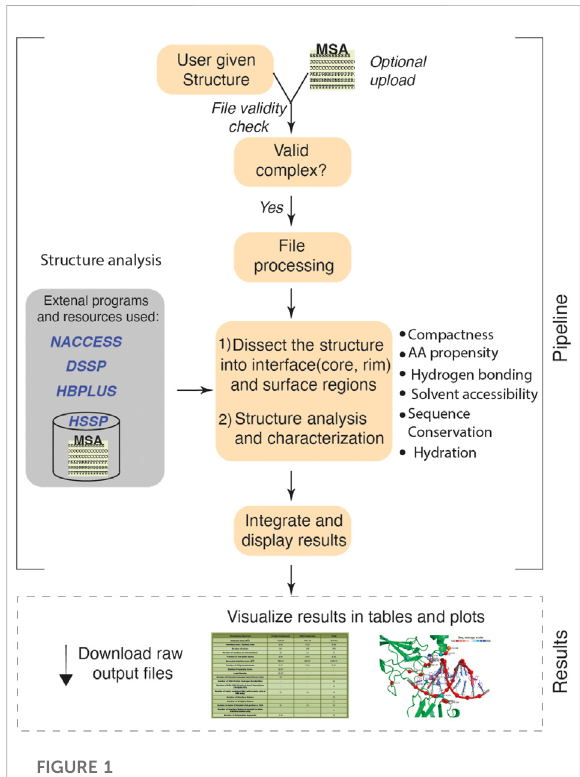
FIGURE 1 Work fl ow of ProDFace. The user uploads a query structure in PDB format. The protein-DNA binding region i.e. the interface and the rest of the surface region are identi fi edfor the whole complex, as well as for the protein and the DNA components. Structural, geometrical and physico-chemical properties of the interface region are calculated. Also, the interface hydration is analyzed. The interface is dissected into core and rim regions depending on their solventaccessibility(Guharoy and Chakrabarti, 2005) and the sequence conservation within these areas is calculated. All these properties have been described previously (Dey et al., 2012). The conserved residues are displayed in a separate